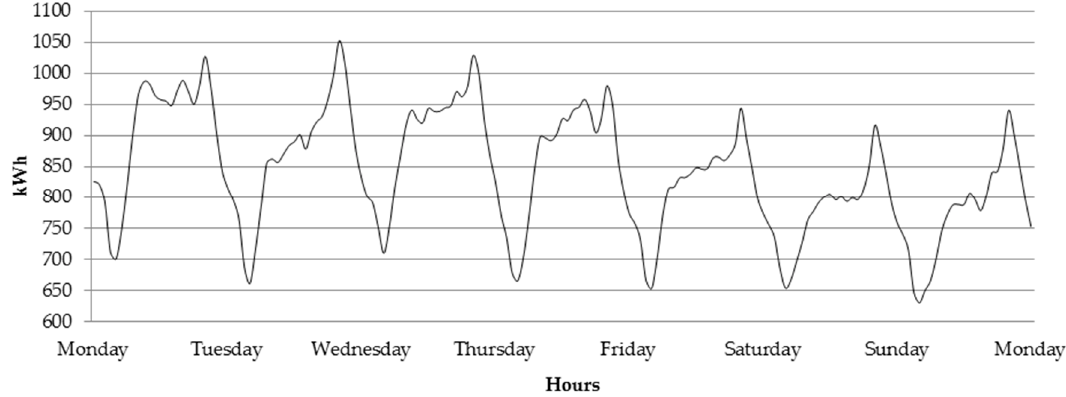
Figure 2. Daily dynamics of the hourly load data observed between 6 July (Monday) and 12 July (Sunday) 2015.